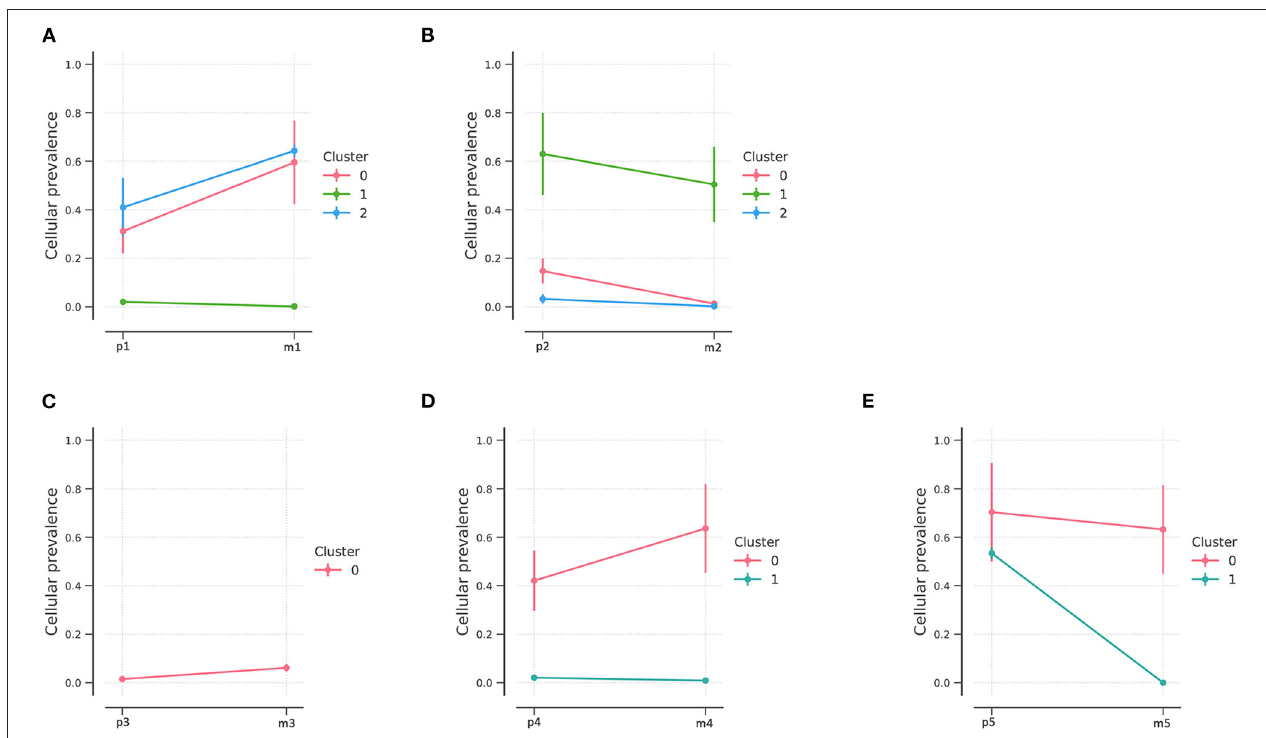
FIGURE 3 | PyClone analysis of the five patients. PyClone quantification of clonal populations in sequenced mutations of patients 1–5 ( A–E , respectively). Cellular prevalence of clonal populations is the mean value of the cellular prevalence of mutations in the cluster. The predicted cellular frequencies represent the proportion of cancer cells in each set of clonal